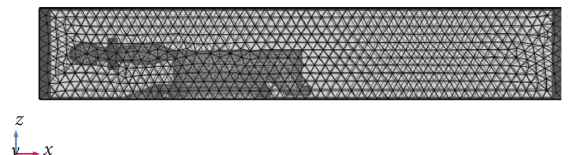
Figure 2: Meshing of the physical model of fully mechanized excavation